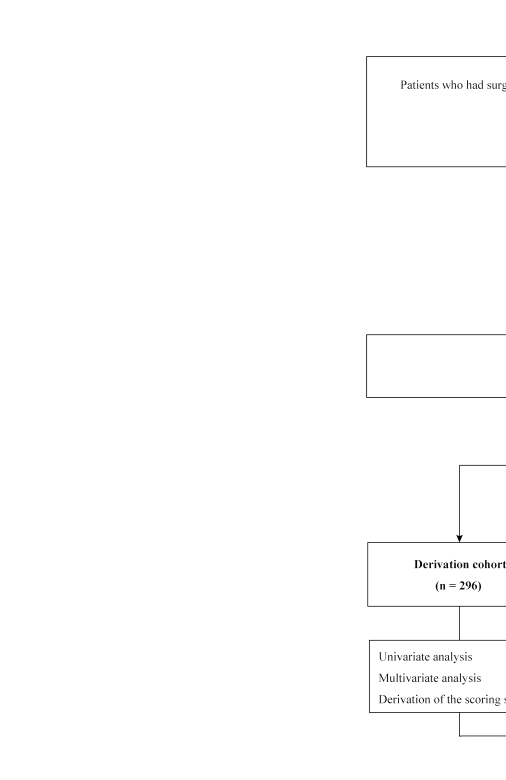
FIGURE 1 Cohort selection fl ow chart. DCIS, ductal carcinoma in situ ; ILC, invasive lobular carcinoma; NAC, neoadjuvant